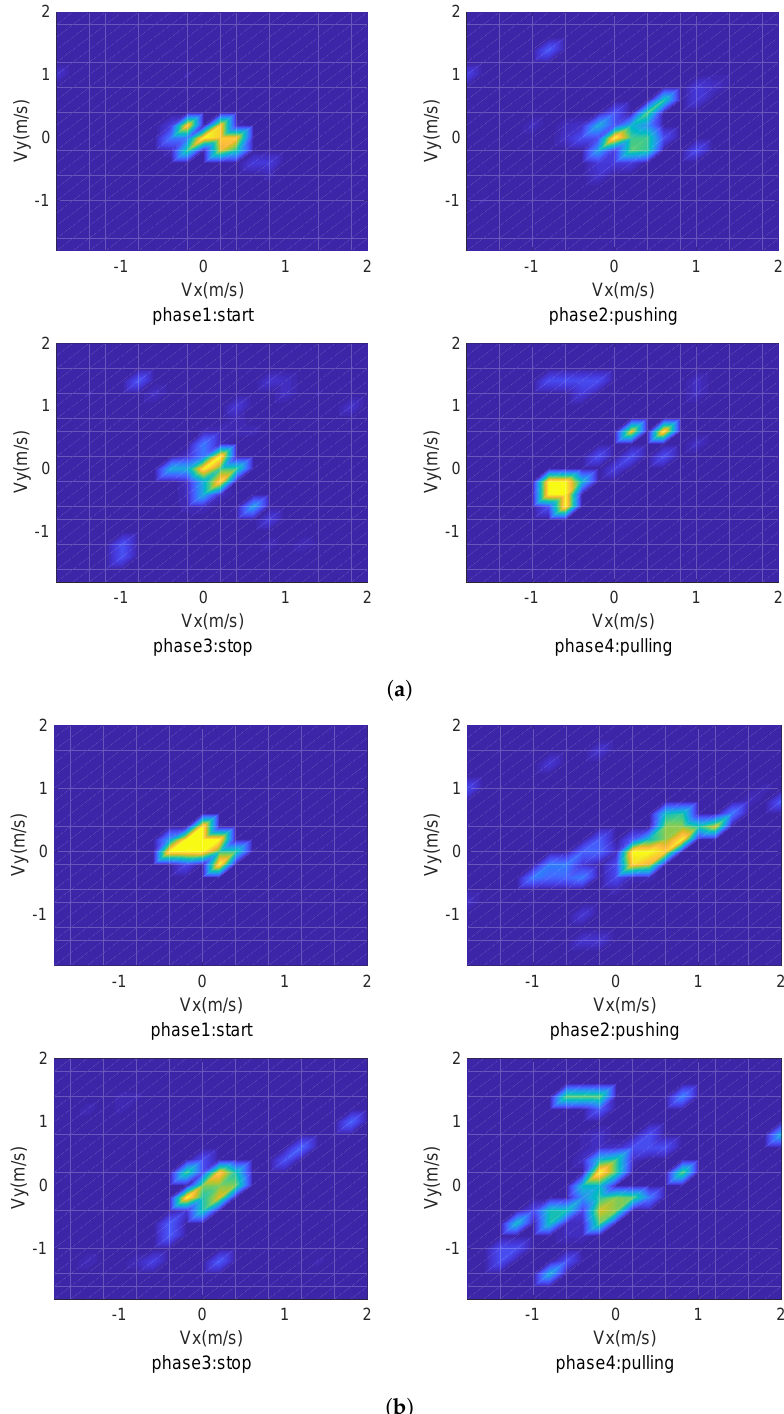
Figure 1. BVP series for different users. ( a ) BVP series of user1. ( b ) BVP series of user2. The training process of federated learning is shown in Figure 2. The server collects the model parameters uploaded by each client in each iteration, and then distributes them to each client after weighted averaging to complete the update of local model